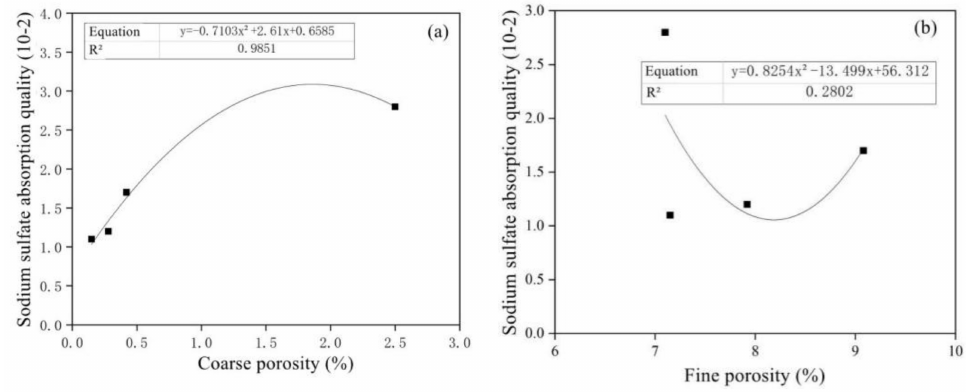
Figure 17. Diagrams of sodium sulfate absorption quality versus coarse ( a ) and fine porosity ( b